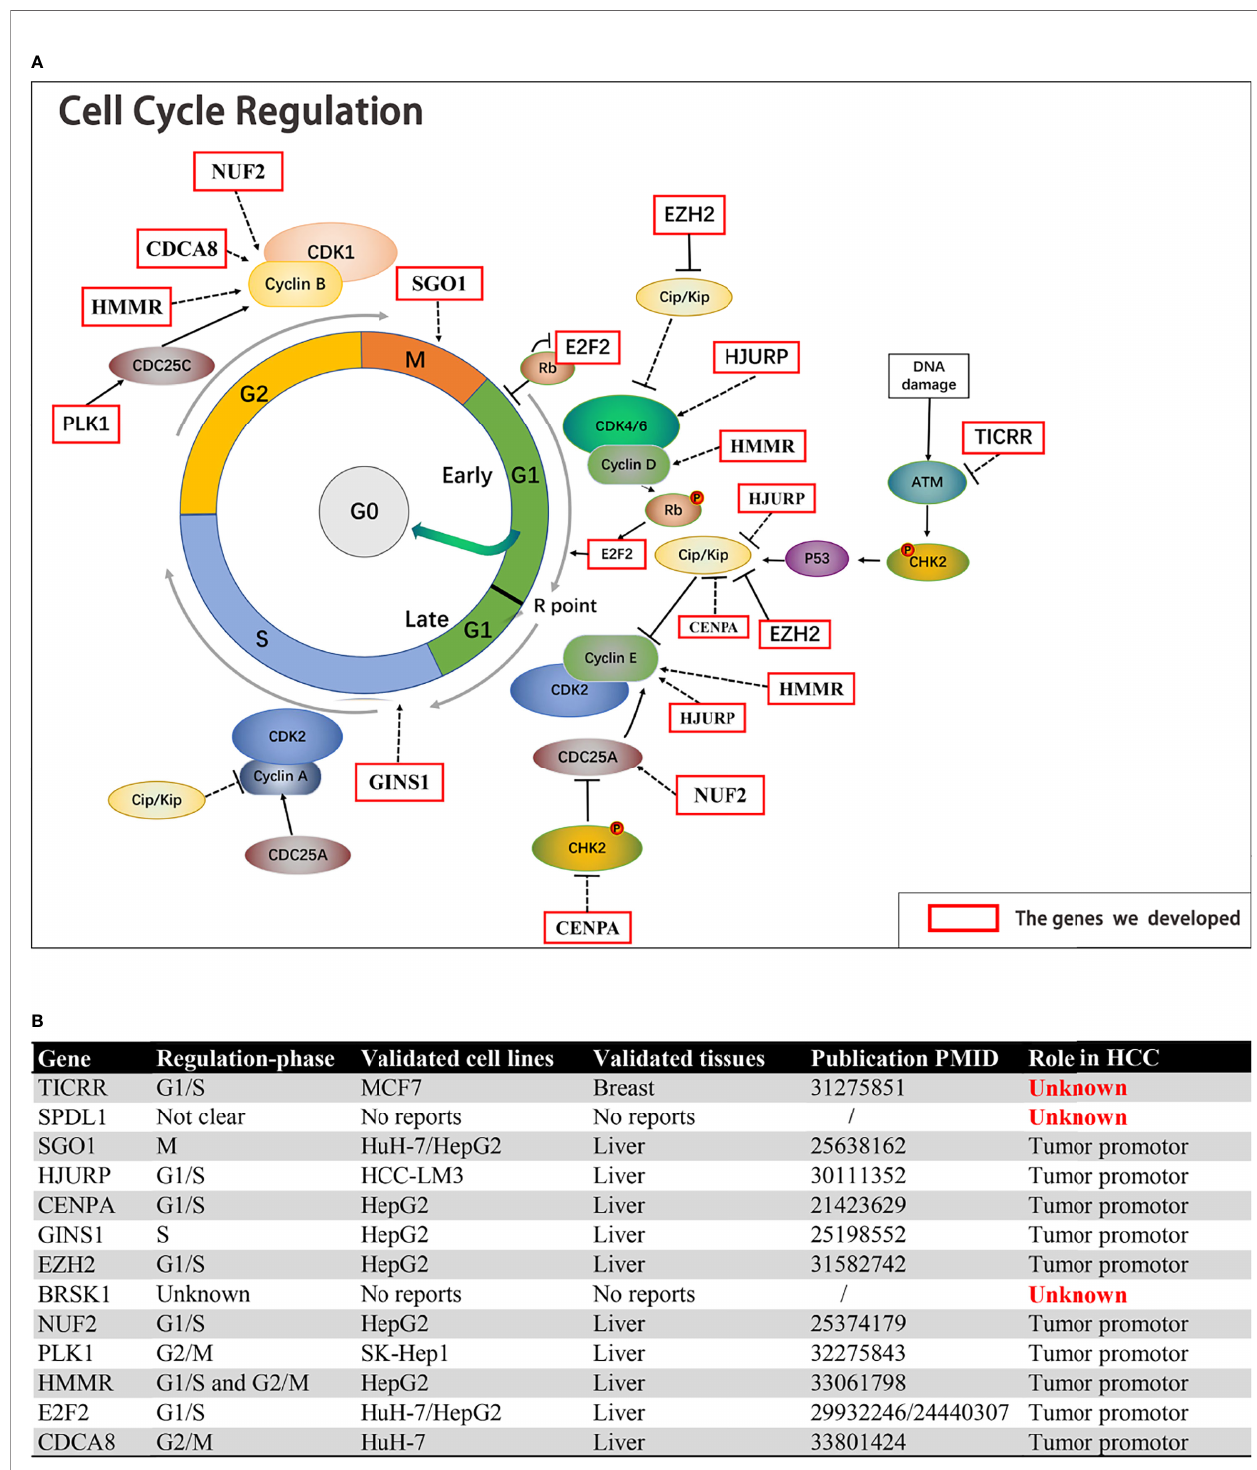
FIGURE 9 | The function of the 13 genes in cell cycle regulation and their roles in HCC. (A, B) Ten of the 13 cell cycle genes, including SGO1, HJURP, CENPA, GINS1, EZH2, NUF2, PLK1, HMMR, E2F2, and CDCA8, were established HCC driver genes. TICRR, SPDL1, and BRSK1 had no con fi rmed role in